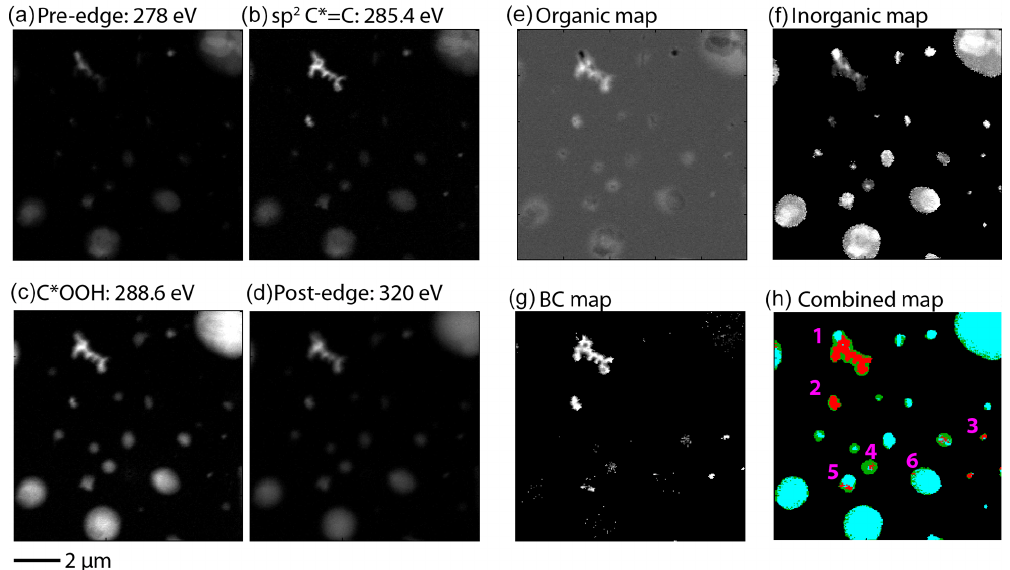
Figure 1. ( a – d ) Single energy images at 278, 285.4, 288.6, and 320eV representing the pre-edge, C* = Csp 2 carbon, C*OOH, and total carbon. (e) Organic map produced by subtracting the image at 278eV from the image at 288.6eV. (f) Inorganic map produced by taking the ratio of the image at 278eV to the image at 320eV (pre-edge: total carbon). (g) sp 2 carbon map derived by multiplying the ratio of 285.4eV to 320eV by a constant to give the percentage of sp 2 bonds as described in Hopkins et al. (2007). (h) Combined maps derived from thresholding of maps; (e) – (g) red areas contain %sp 2 >35%, green areas are organic dominant, and blue areas are non-carbonaceous inorganic